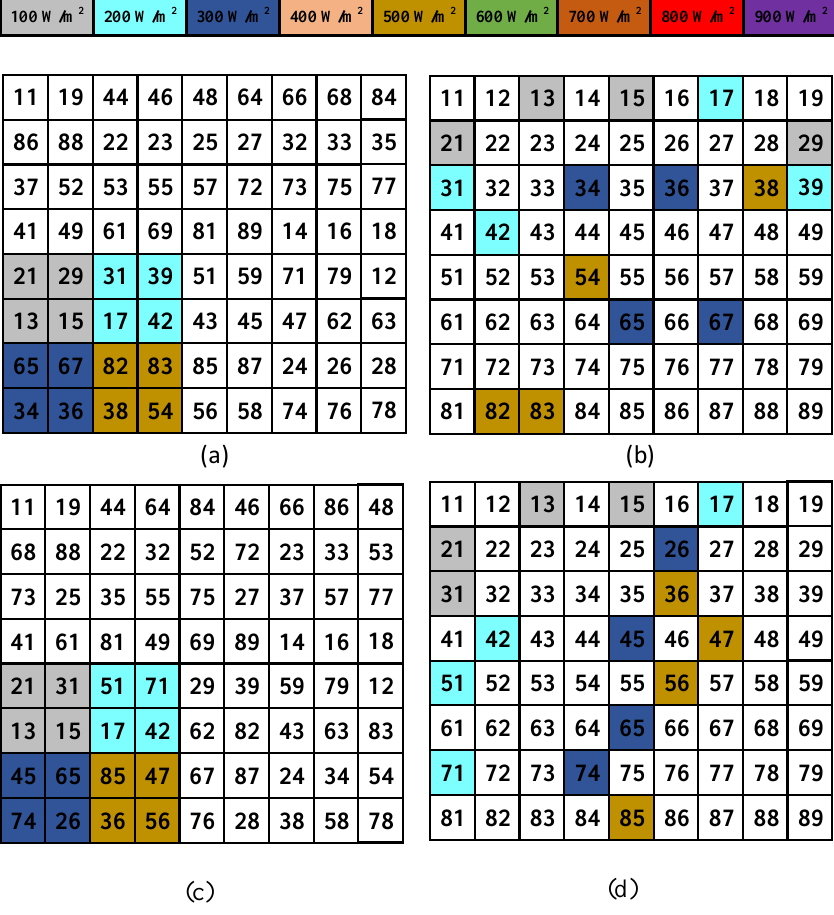
Figure 20. ( a ) OEP; ( b ) shade dispersion of OEP; ( c ) IOEP; and ( d ) shade dispersion of IOEP for Case-3 (Bottom-Left) PSC. The voltage–power characteristics of case-3 (Bottom-Left) are shown in the Figure 21. From the voltage–power characteristics, it understood that IOEP reconfiguration has supe- rior performance under partial-shading conditions.